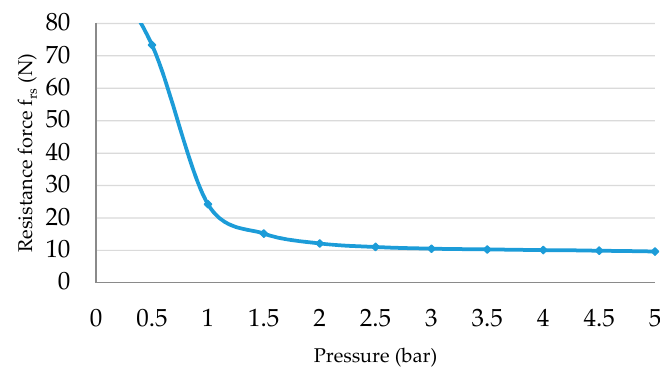
Figure 10. The resistance force of the high stiffness rubber tube against air pressure.